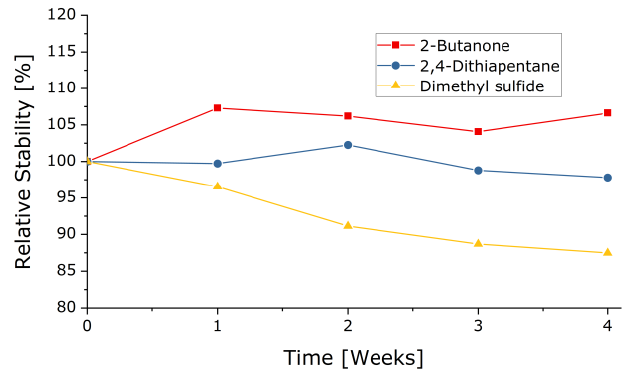
Figure 5. Stability study of selected sample compounds.